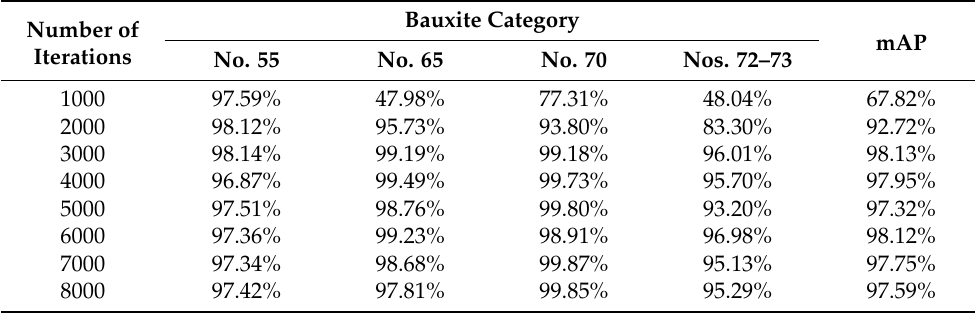
Table 3. Training results of improved YOLOv4 network for unbalanced category datasets. Number